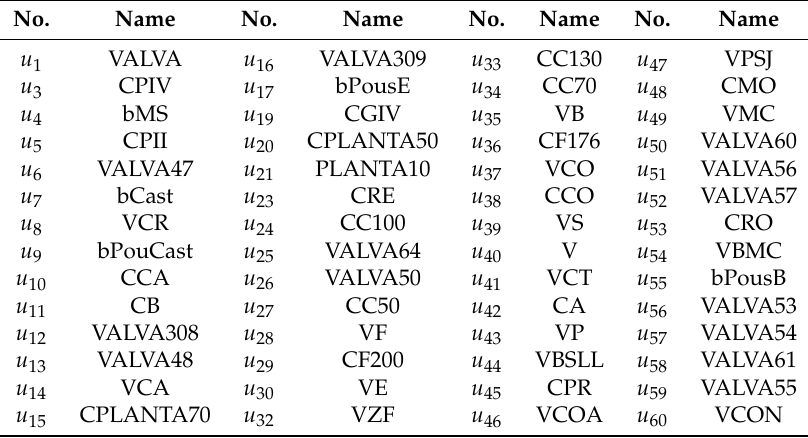
Table 3. Structural actuators (towards tanks).